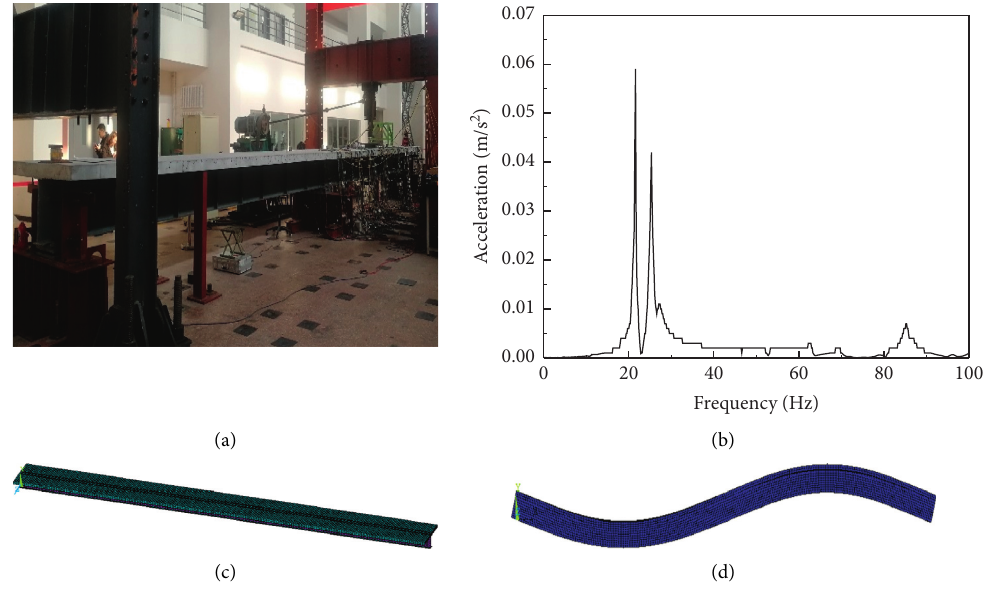
Figure 6: The shear-slip curve of a single stud ( Q-s ).